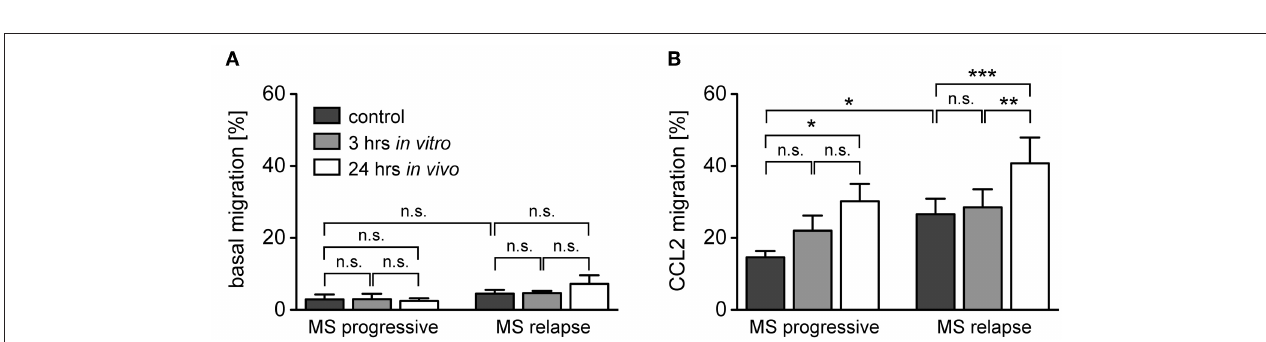
FIGURE 6 | Monocyte migration along chemokine gradients in healthy subjects and MS patients under the influence of GCs. Monocytes were isolated from healthy subjects and MS patients before and after (24h in vivo ) MP pulse therapy. Cells were cultured in the absence (control) or presence of 10 − 6 M MP for 3h in vitro and then transferred into the upper part of a Boyden chamber. Basal monocyte migration without a chemokine gradient (A) and migration toward a gradient of CCL2 (B) , CCL5 (C), or CX3CL1 (D) into the lower part of the Boyden chamber were analyzed by flow cytometry and results are depicted as the percentage of transmigrated cells (mean ± SEM). n = 19/19/11/9 (healthy subjects), n = 13/15/12/17 (MS patients). For statistical analysis, untreated samples were compared to each other using a t -test, comparison of untreated vs. MP-treated samples from healthy subjects was performed using a paired t -test, and comparison of samples from MS patients to each other was performed using a One-way ANOVA and Newman-Keuls Multiple Comparison test. Levels of significance: n.s. p ≥ 0.05; * p < 0.05; ** p < 0.01; *** p < 0.001.